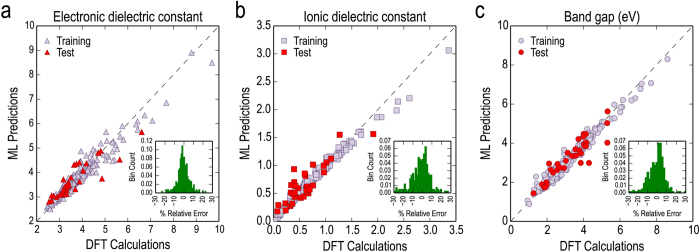
Prediction model performances.Comparison of the KRR property predictions with DFT evaluated properties for the prediction models for ϵelec, ϵionic and Egap respectively.